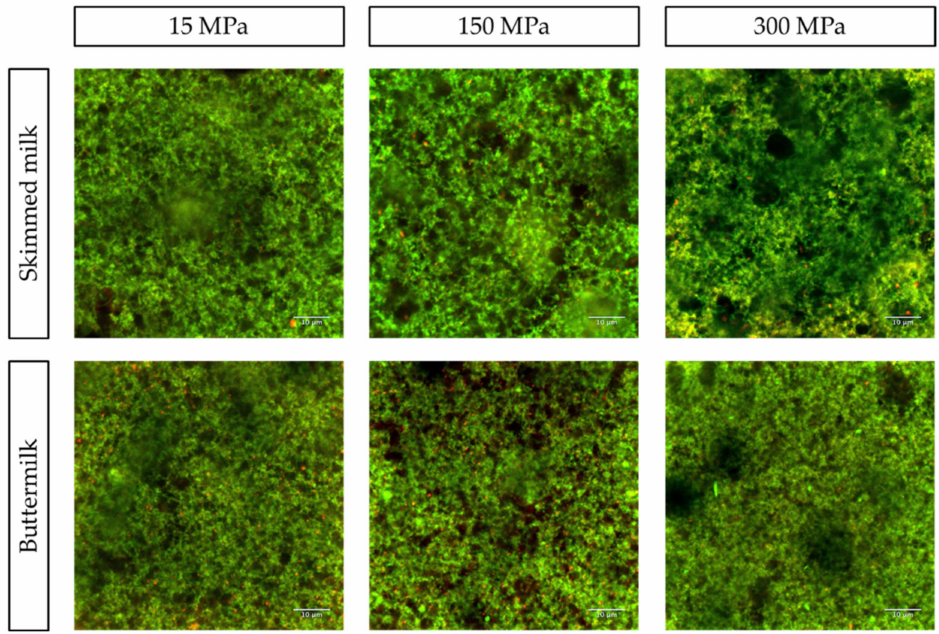
Figure 4. Confocal laser scanning microscopy (CLSM) images of set skimmed milk (SM) and buttermilk (BM) yogurts with different pressure applications (15, 150, and 300 MPa). Red color represents the phospholipids (PLs) labeled with Nile Red; green color represents the milk proteins labeled with Fast Green FCF. Scale bar (10 µ